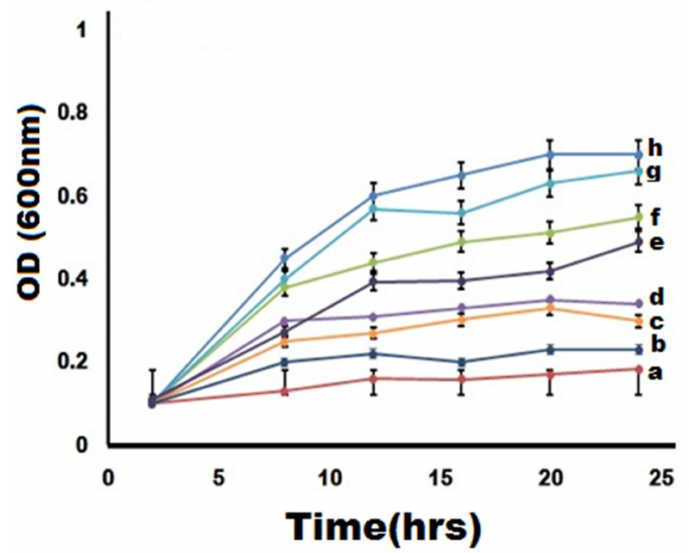
Figure 7. Killing kinetics of greenly synthesized nanomaterials (at MIC) against MDR E. coli -induced mastitis. ( a ) Negative control (autoclaved MHB only), ( b ) CIP-Ag/TiO 2 /Fe 2 O 3 /CS nanocomposite (NDDS), ( c ) Ag/TiO 2 /Fe 2 O 3 /CS, ( d ) Ag/TiO 2 /Fe 2 O 3 , ( e ) Fe 2 O 3 nanorods, ( f ) CS NPs, ( g ) CIP (at MIC), and ( h ) positive control (inoculated in MHB only).